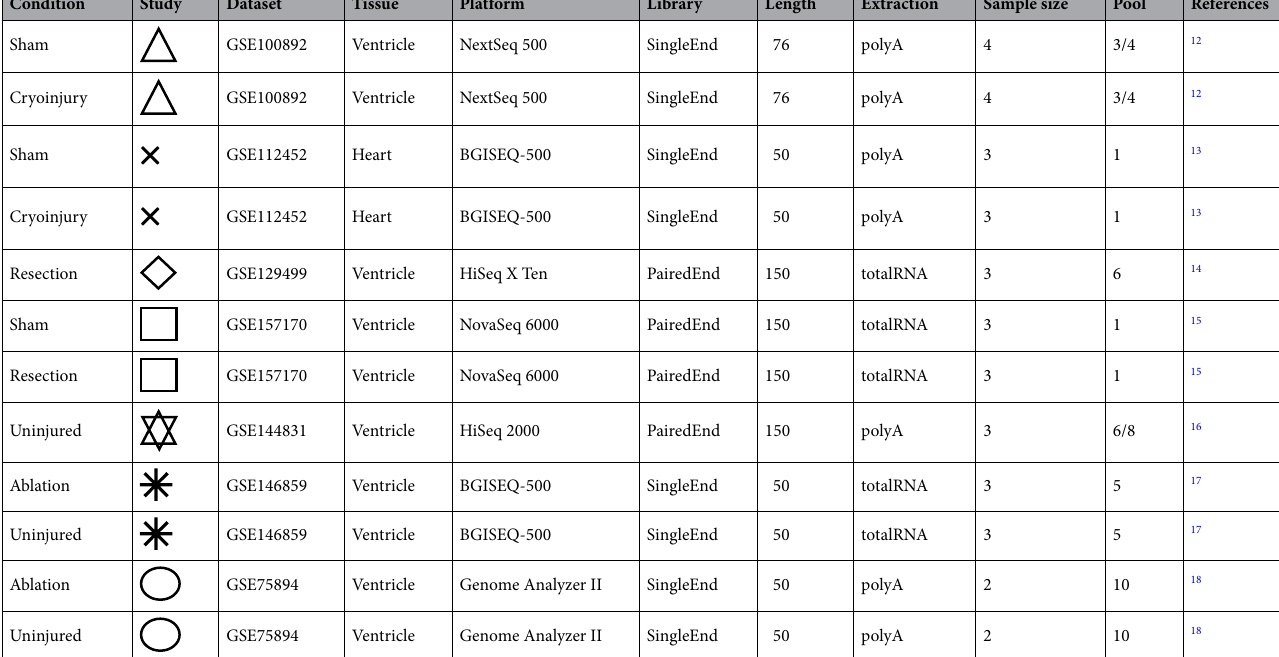
Table 1. RNA-seq Dataset of 7 days postinjury (dpi) hearts used for the meta-analysis. NCBI GEO database (https:// www. ncbi. nlm. nih. gov/ geo/) was queried for RNA-seq studies using different heart injury models in zebrafish at 7 dpi. Metadata is presented in the table columns. Condition : defines the heart injury model used for this dataset, uninjured hearts, and sham procedure (mock chest surgery). Study : shapes are representing the datasets lab of origin. Dataset : GEO IDs to track the sample. Tissue : biological part used for the sequencing, full heart, or ventricle. Platform : specifies the sequencing machine used for the experiment. Library : sequencing library used in the experiment consisting of single or pair ended reads. Length : defines the sequencing read lengths. Extraction: protocol used to enrich the mRNAs, oligodT or totalRNA kits. Pool : number of hearts or ventricles that a sample is composed